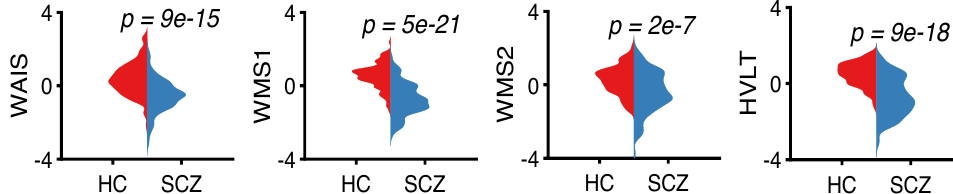
Figure 6. The four behavioral features used in this study are collected using the letter-number sequence subtest of WAIS-III (WAIS), the face recognition subtest of WMS-III (WMS1), and the logical memory test of WMS-III (WMS2) and HVLT (HVLT). The behavioral feature WAIS measures the working memory, WMS1 measures the visual memory, and WMS2 and HVLT measure the verbal memory and learning. All four features show strong group differences ( p < 0.05) between healthy controls and patients with